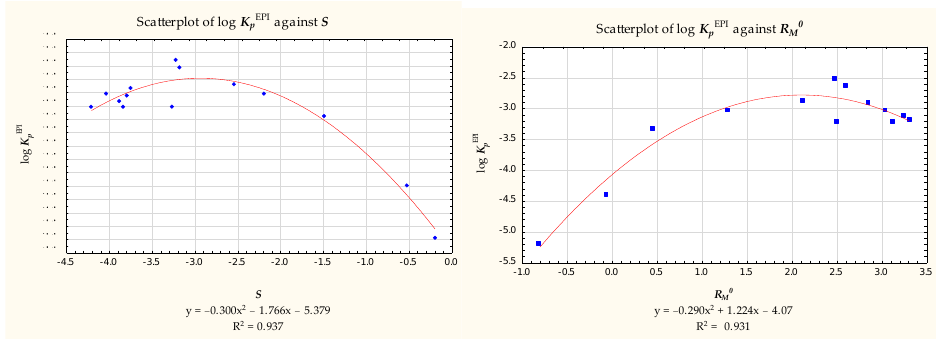
Figure 1. Scatterplots of log K p EPI vs. S and R M 0 ( n = 14).